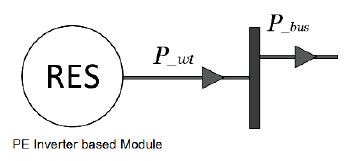
Figure 6. Connection of a decoupled WT to the system, indicating the inputs for VSP-based FAPR.